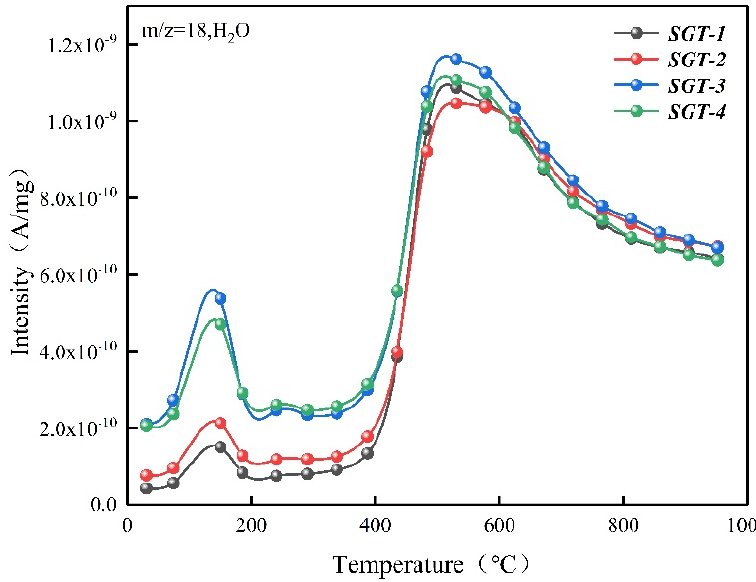
Figure 5. Evolution curves of H 2 O.